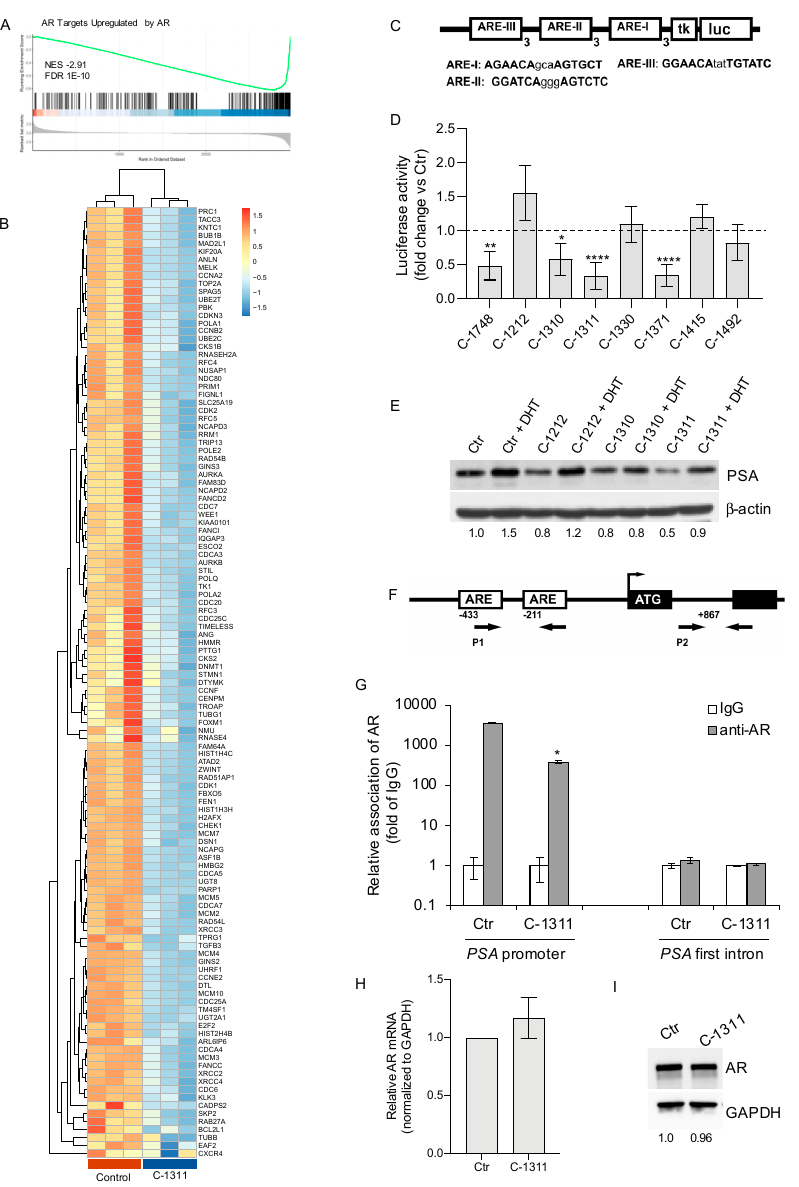
Figure 3. C-1311 blocks transcriptional activity of the androgen receptor (AR). ( A ) Gene Set Enrichment Analysis (GSEA) plot showing repression of the ‘AR Targets Upregulated by the AR’ gene signature in LNCaP cells treated with 1 µM C-1311 for 24 h. ( B ) Heat map of DEGs (|log2FC|> 1, FDR < 0.05) identified from the ‘AR Targets Upregulates by AR’ gene signature in LNCaP cells treated with 1 µM C-1311 for 24 h. ( C ) Schematic representation of the ARE-Luc reporter vector